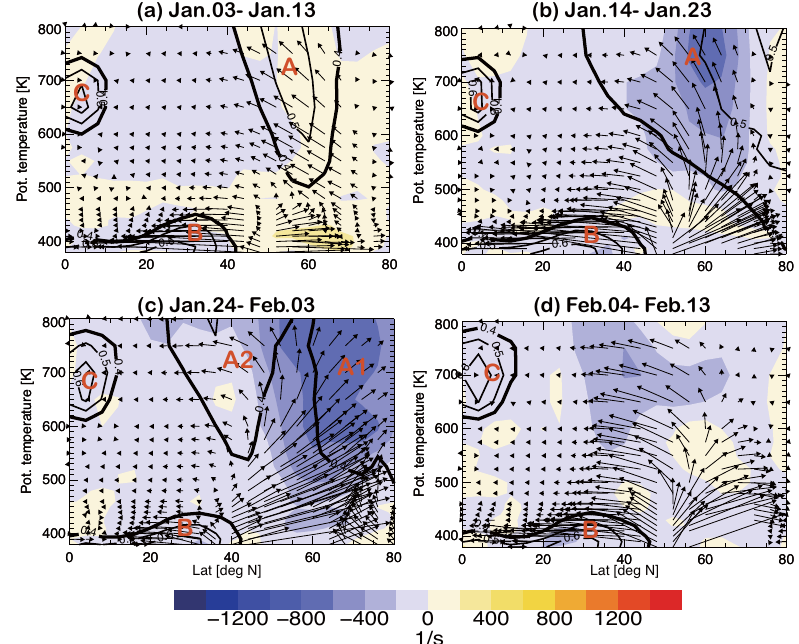
Figure 7. EP flux (arrows) and its divergence (coloured bluish). Black contours indicate the mixing intensity larger than 0.4. The panels (a) – (d) show mean values averaged over four time periods: (a) 3–13 January, (b) 14–23 January, (c) 24 January–3 February and (d) 4–13